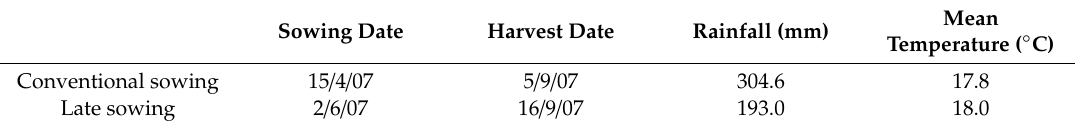
Table 1. Rainfall (mm) and mean daily temperature (°C) during the growing season of the two trials.